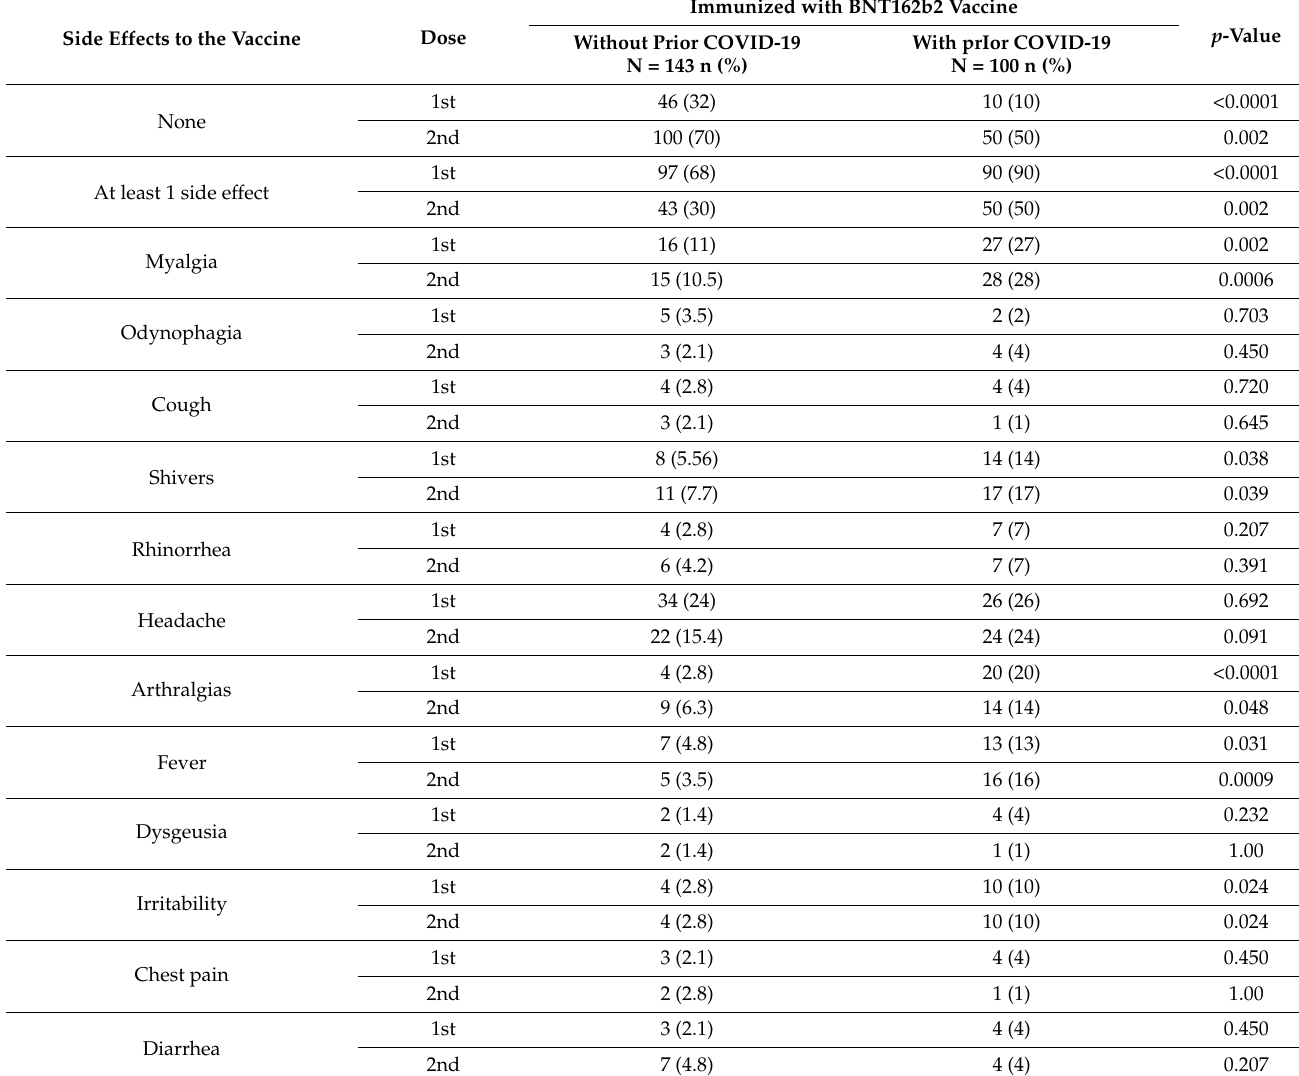
Table 2. Side effects to BNT162b2 vaccine after the first and second